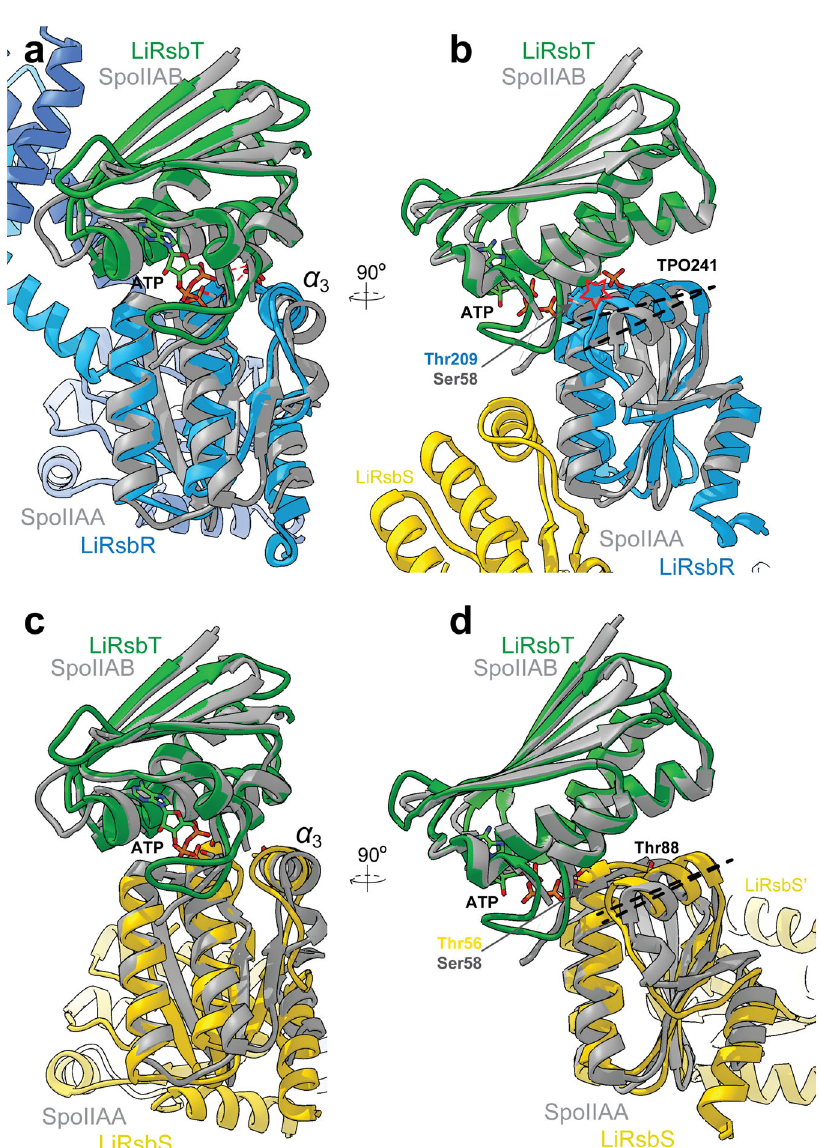
Fig. 5 Docking of Li RsbT to Li RsbS and Li RsbR. a Superposition of Li RsbR model (in blue color) with a crystal structure of SpoIIAA (gray) in complex with the ADP-bound SpoIIAB (pdb entry 1TH8 gray color). A homology model of ADP-bound Li RsbT (in green color) is aligned matching the orientation in the SpoIIAB complex, while SpoIIAA is aligned to the STAS domain of Li RsbR. b Close-up view of the STAS domain superposition in ( a ) rotated by 90° (color coding as in a ). Phosphorylation sites and the respective interacting sidechains are shown as stick models (carbon atoms in blue or yellow, respectively, oxygen atoms in red, and nitrogen atoms in dark blue). The relative conformational difference between the not phosphorylated SpoIIAA from B. subtilis and the phosphorylated Li RsbR is indicated by the dashed lines, and the model clash indicated by a red star. c Superposition of Li RsbS model (in yellow color) with the SpoIIAA in complex with ATP-bound SpoIIAB (in gray color). A homology model of ATP-bound Li RsbT (in green color) is aligned to Li RsbS matching the orientation of SpoIIAB in the SpoIIAA:SpoIIAB in complex. A 90 ˚ rotated view can be seen in ( d